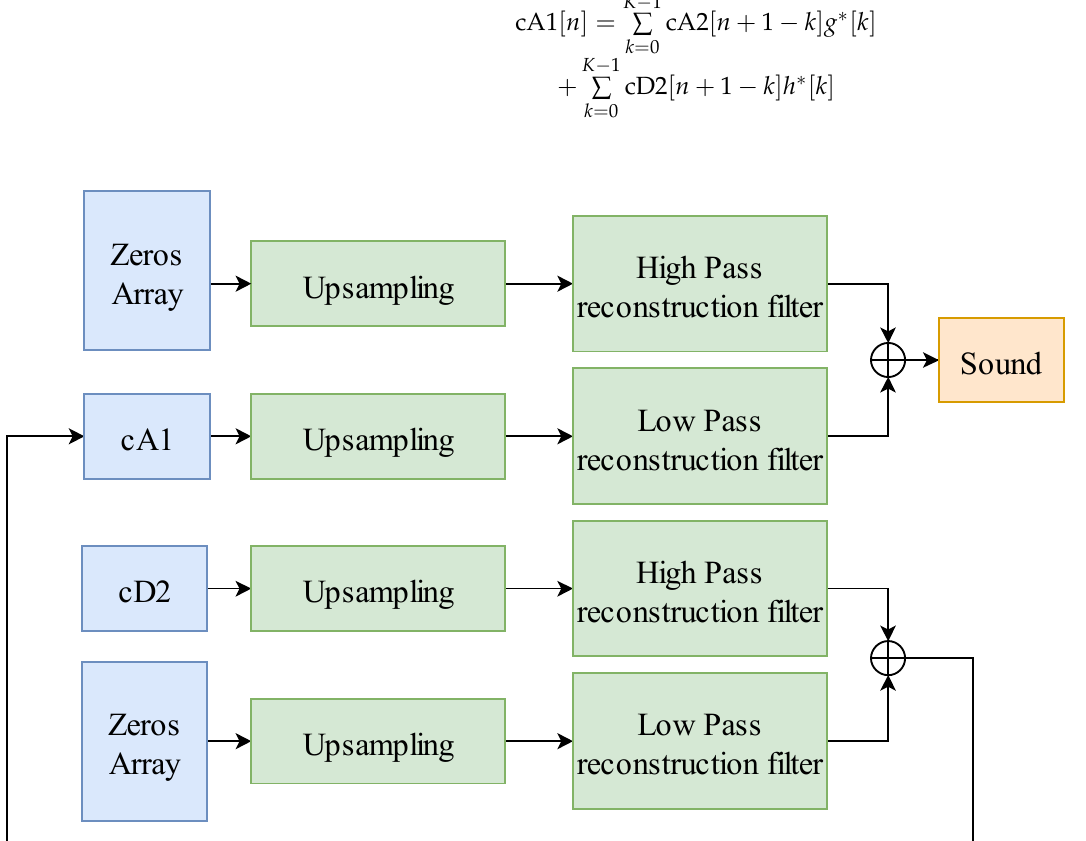
Figure 5. Two-level wavelet reconstruction.